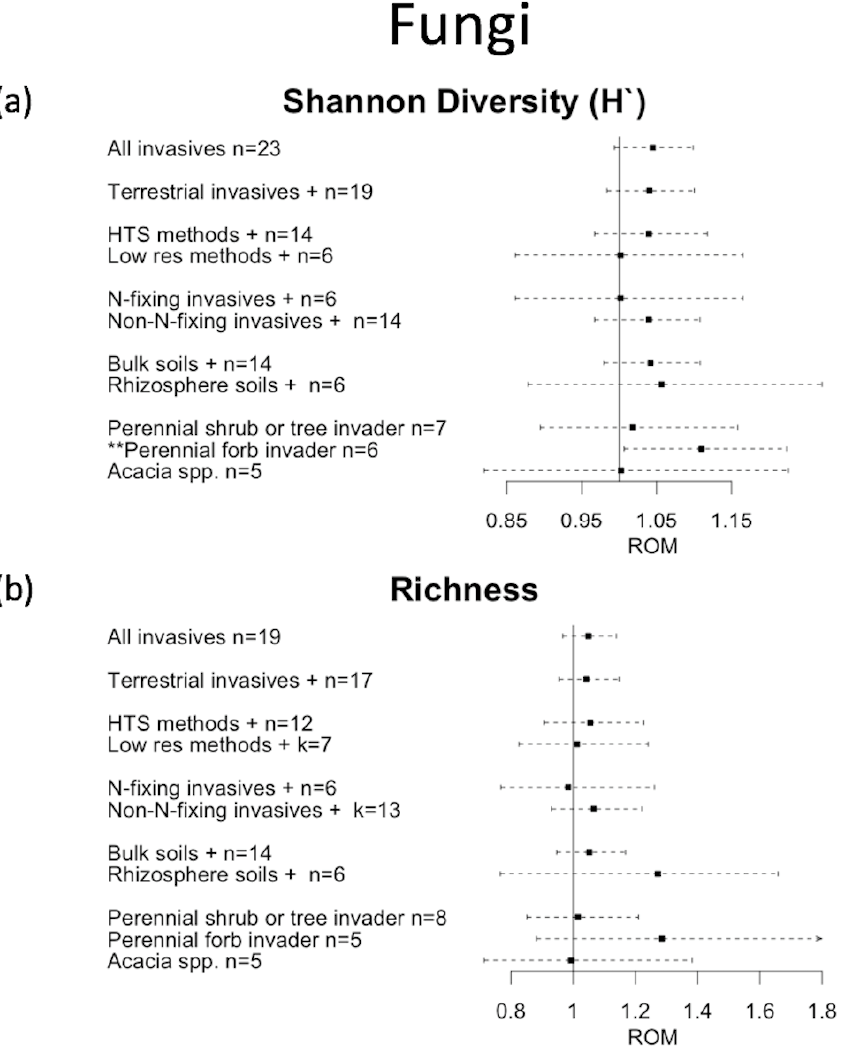
Figure 2. Forest plot of fungal weighted response ratio (ROM) following invasion. ** indicates statistical significance in at least one model. The symbol “+” indicates only terrestrial studies were used in the calculation of the ROM, and “-” indicates only wetland studies were used. Additional information on which model produced statistical significance can be found in supplementary table S3. The most conservative model results are presented in this figure. The top line is all fungal studies examined together. Plots are then sorted by subgroups. Labels include subgrouping and number of independent studies (n). Both panels follow the same formatting. ( a ) Weighted response ratio (ROM) of fungal Shannon diversity (H`); ( b ) Weighted response ratio (ROM) of fungal richness.